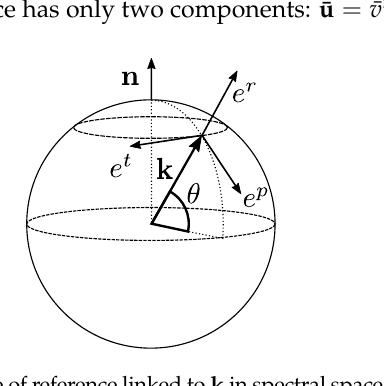
Figure A2. The polar-spherical frame of reference linked to k in spectral space, also named Craya–Herring frame. Unit vectors are toroidal e t , poloidal e p , and radial e r